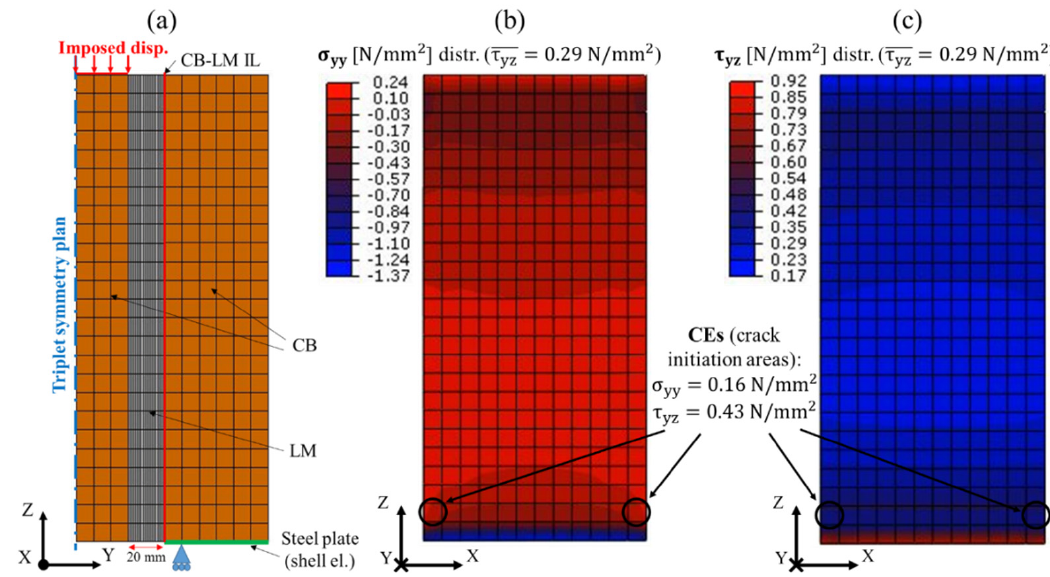
Figure 7. ( a ) Triplet model set-up; ( b ) normal stress and ( c ) shear stress distributions in the CB-LM IL for τ yz = f v0